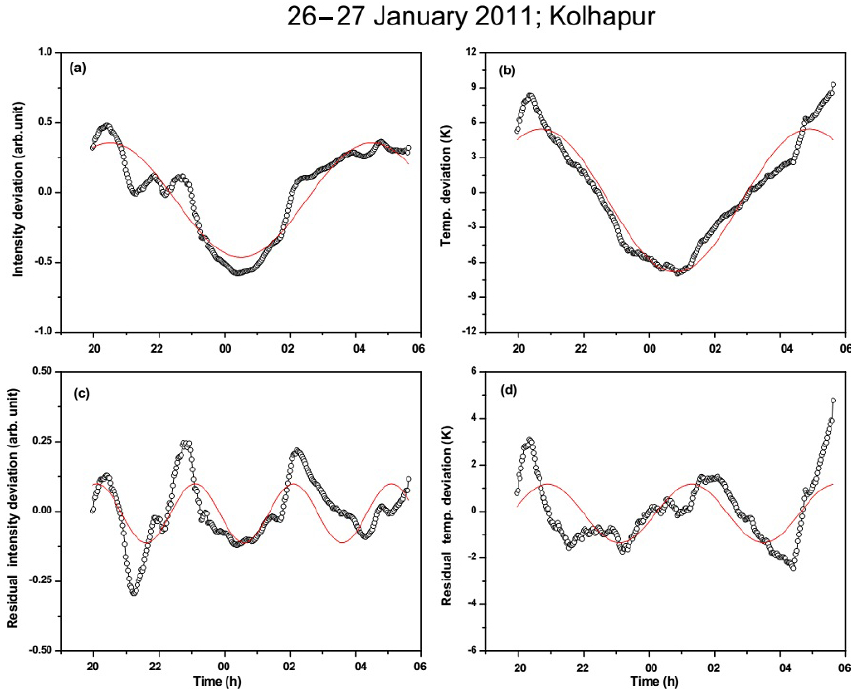
Figure 1. Nocturnal variability in the mesospheric OH emissions on 26–27 January 2011. The upper panels represent the mean deviations in (a) intensity and (b) temperature data. Bottom panels represent (c) intensity and (d) temperature residuals. Solid red curves in each plot show the result of the simple best-fit cosine